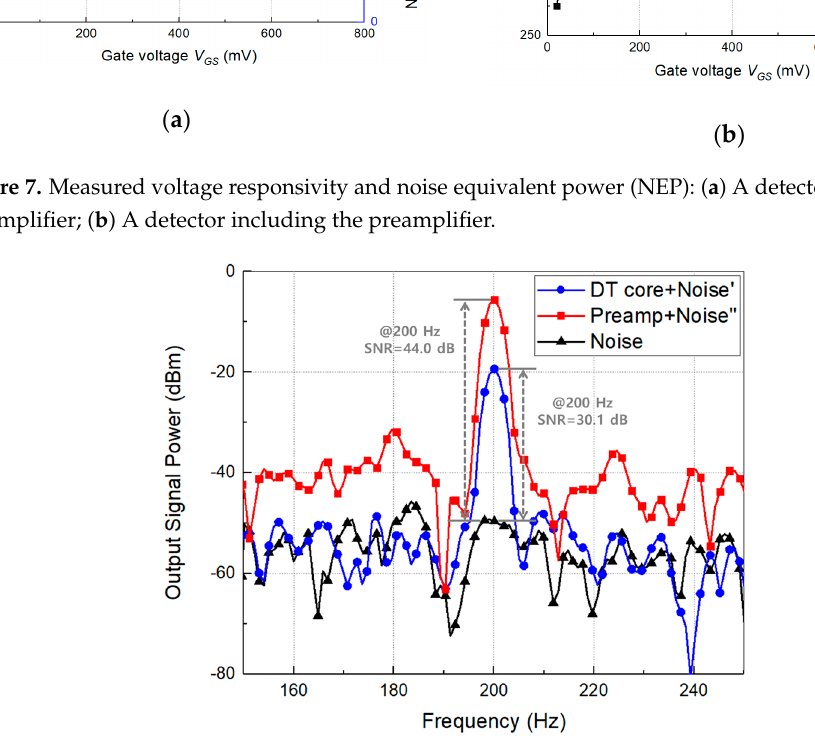
Figure 8. Signal-to-noise ratio at the outputs of the two detector integrated circuits using the modulation frequency of 200 Hz in the harmonic mixer. Table 1. Comparison of the CMOS detector performances